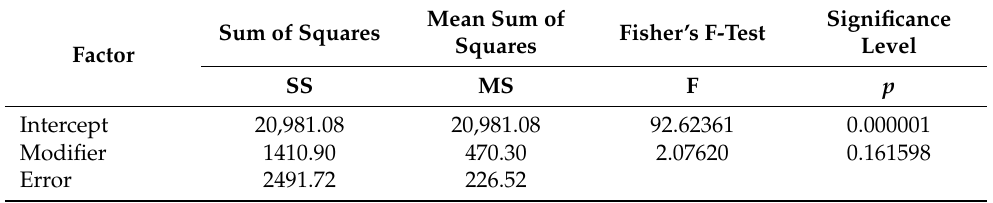
Table 6. Statistical evaluation (ANOVA) of the influence kind of implementation on the growth of Trichoderma viride on the bacterial cellulose surface. Mean Sum of Sum of Squares Fisher’s F-Test Squares Factor